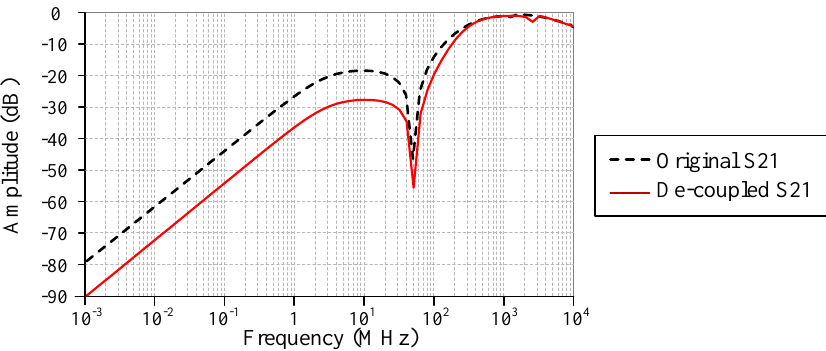
Figure 18. Calculation result of the ADC peripheral circuit model S21 of the acquisition card.